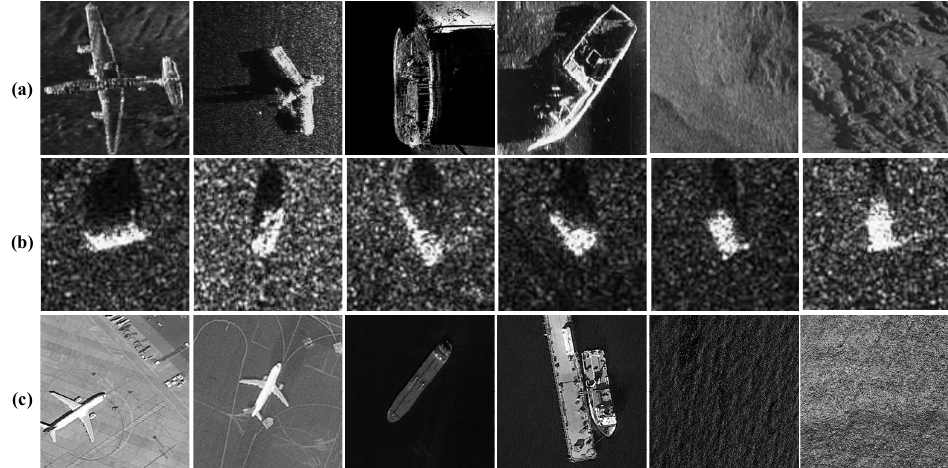
Figure 7. The datasets used in the experiments: ( a ) SSS image samples; ( b )SAR image samples; ( c ) Grayscale optical image samples.